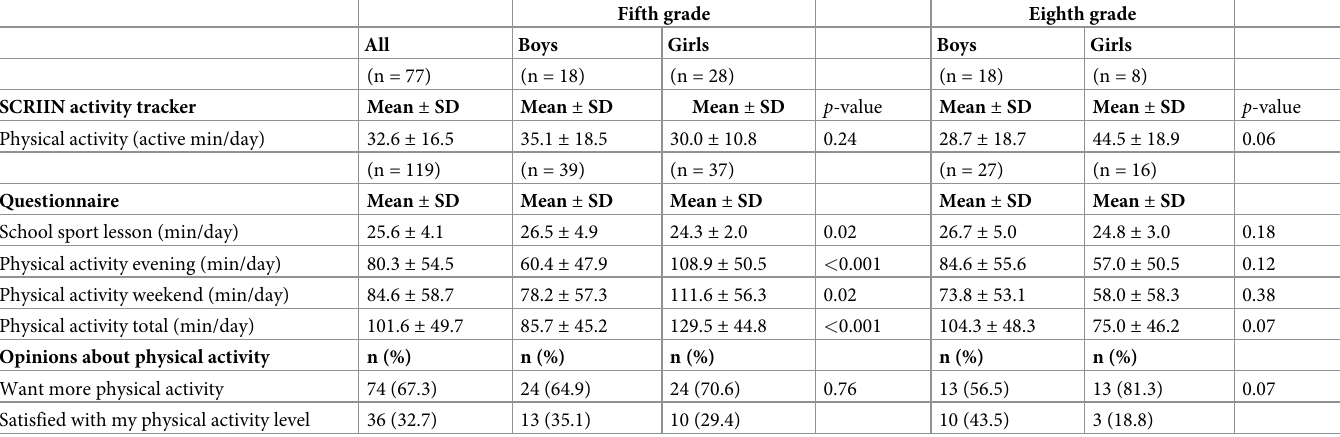
Table 4. Physical activity from SCRIIN activity tracker and questionnaire, all and stratified by grade and sex. Fifth grade Eighth grade All Boys Girls Boys